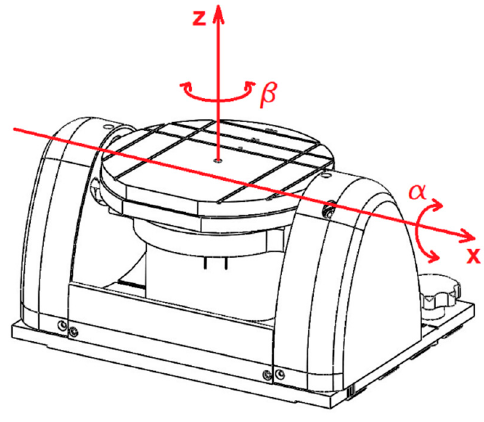
Figure 3. The mechanical assembly DoFs.